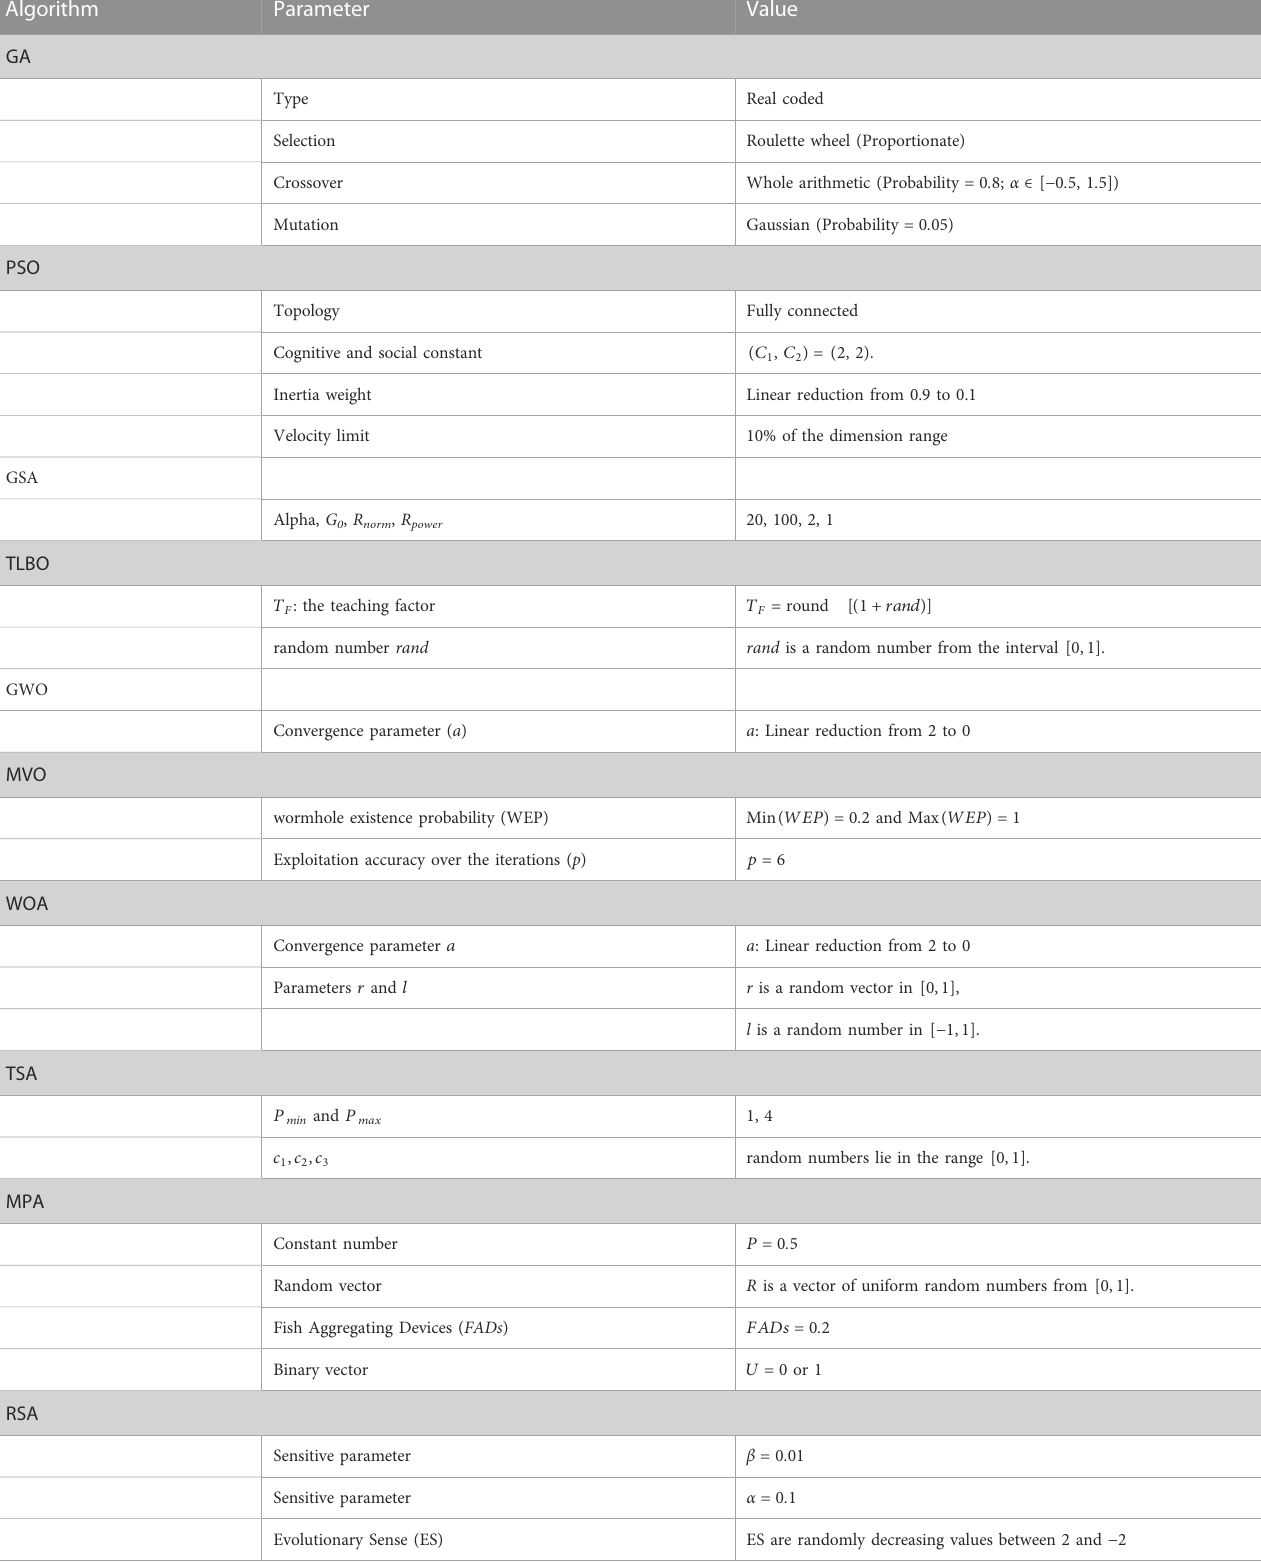
TABLE 1 Parameter values for the competitor algorithms.